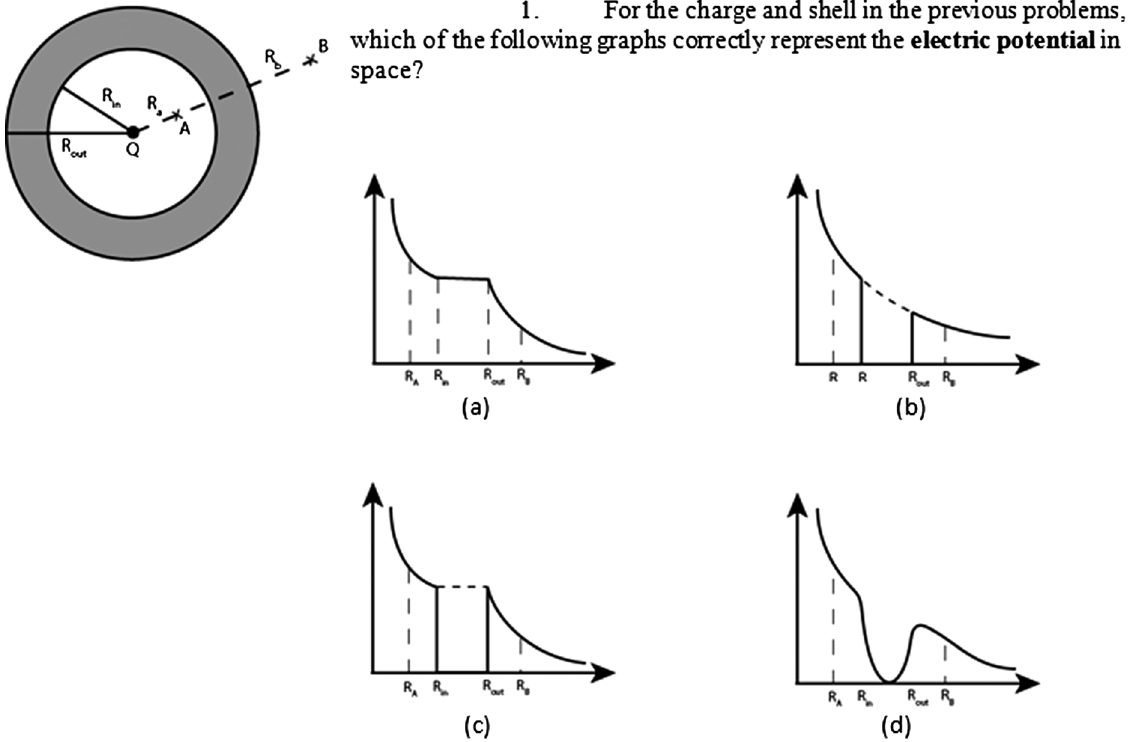
FIG. 16. Post-test problem